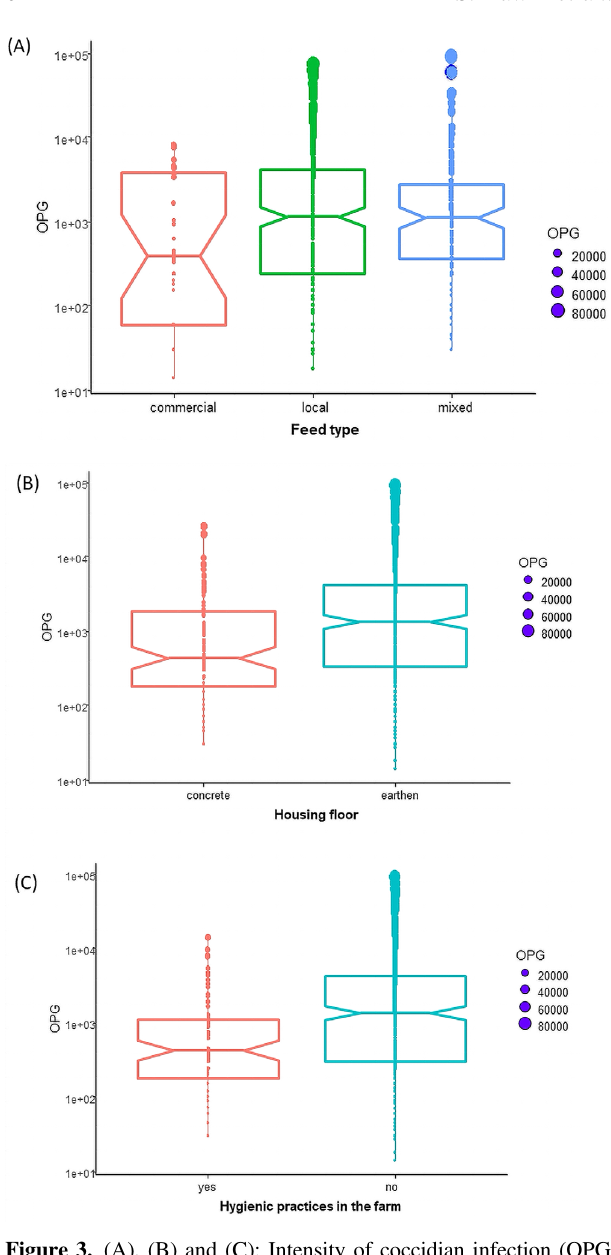
Figure 3. (A), (B) and (C): Intensity of coccidian infection (OPG) was lower in pigs fed with commercial feed than local and mixed feed ( p < 0.05) (A), higher in pigs reared on earthen fl oors ( p < 0.05) (B), and farms with no hygiene practices (C). The top and bottom horizontal lines of boxplots represent the fi rst and third quartiles of the data range, respectively. The medians are shown by middle horizontal lines, and the data range is shown by vertical lines, with outliers plotted as points. The notches of each boxplot are approximate 95% con fi dence intervals of medians. OPGs are described in log